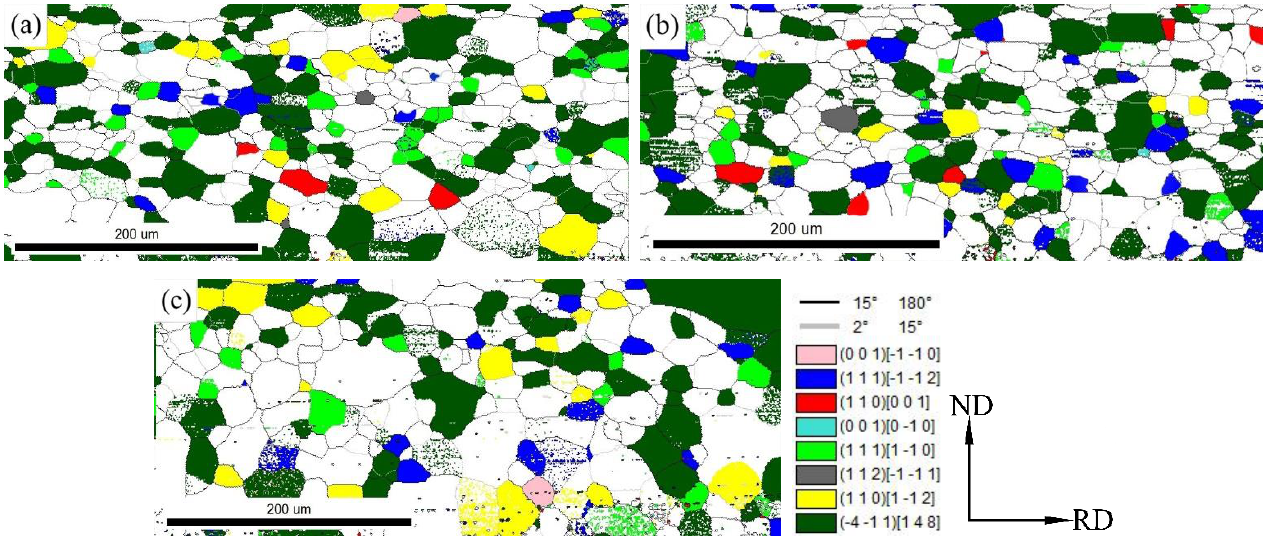
Figure 3. EBSD orientation maps of decarbonized annealing samples along the thickness direction: ( a ) 850 ◦ C × 3 min; ( b ) 850 ◦ C × 5 min; ( c ) 850 ◦ C × 7 min. Table 2. Content of main texture of decarbonized annealing samples (%).